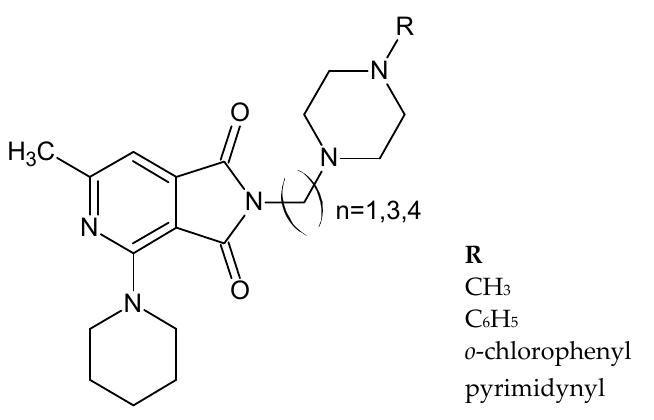
Figure 20. General structure pyrrolo[3,4 ‐ c ]pyridines [27].